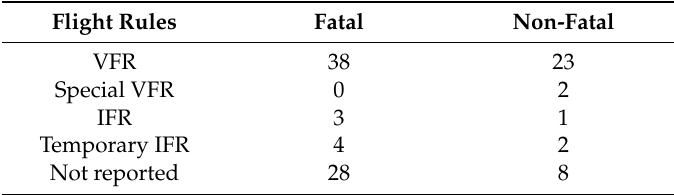
Table 2. Flight rules reported for fog-related helicopter